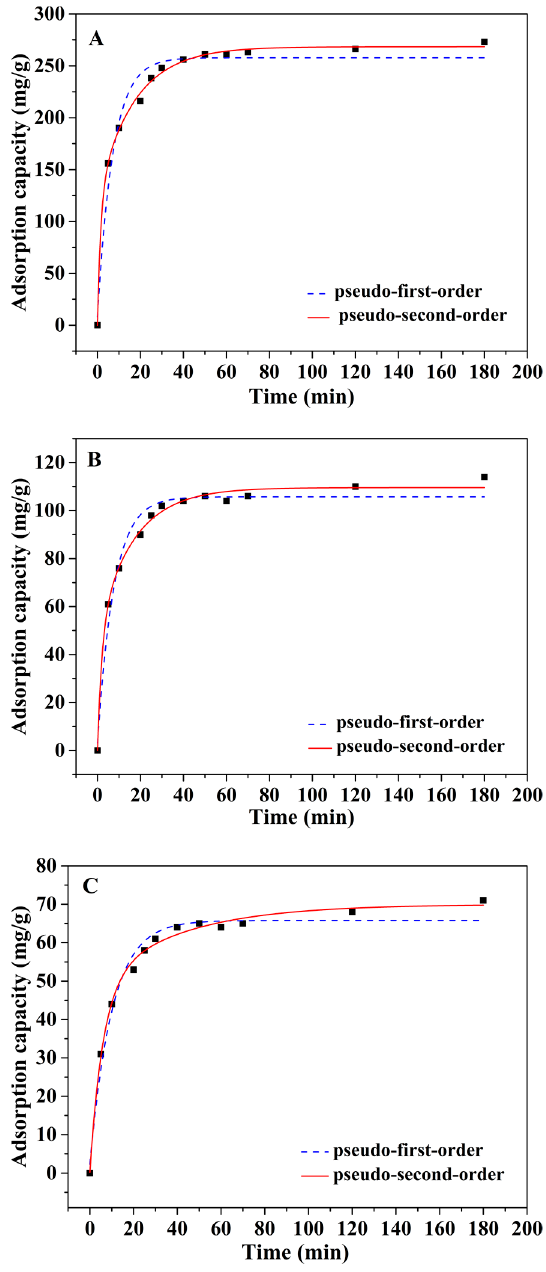
Figure 5. Adsorption kinetics studies of the ( A ) Pb 2+ , ( B ) Cd 2+ , and ( C ) Cu 2+ . (~ 50 mg of mp-CA/GO was equilibrated with 50 mL of 1.5 mM Pb 2+ , Cu 2+ , or Cd 2+ solution at 25 ◦